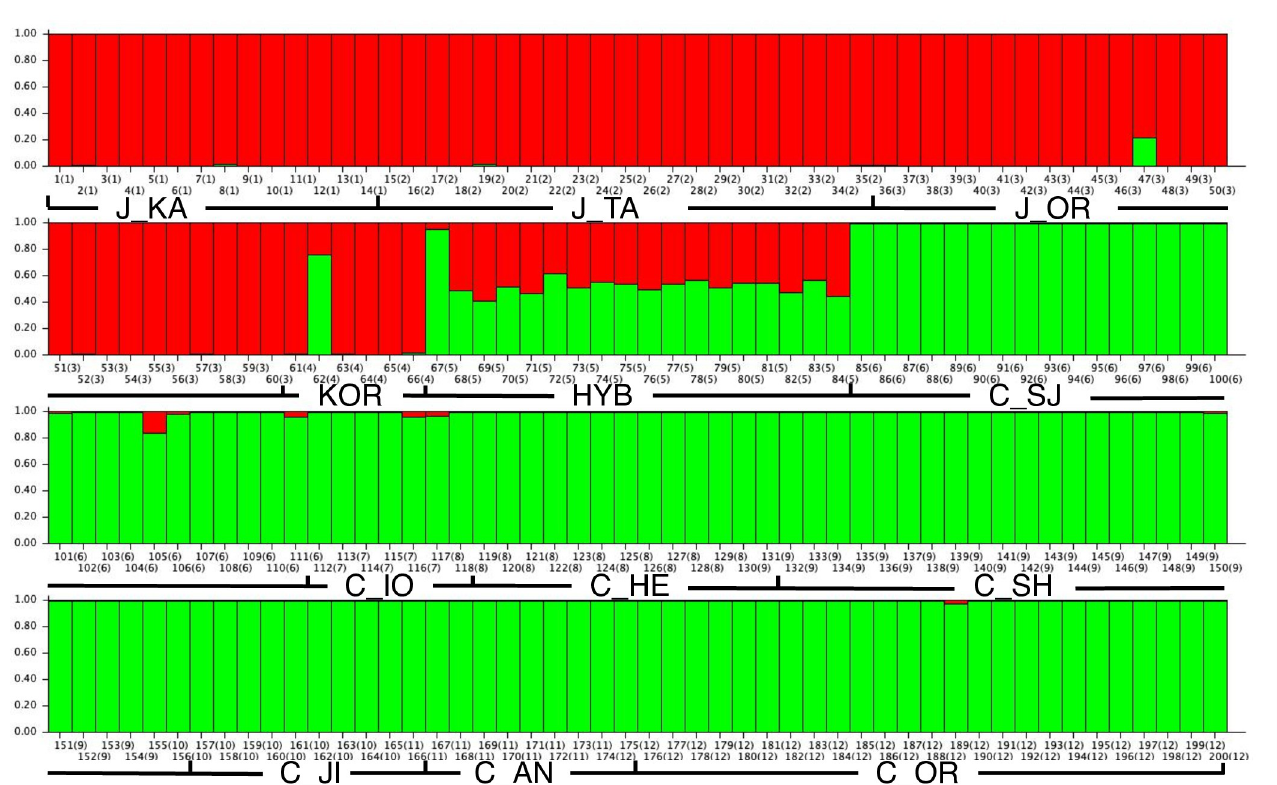
Fig 1. Detailed bar plot diagram for K = 2 in the independent model using 66 Japanese chestnut cultivars, 18 Japanese–Chinese hybrids, and 116 Chinese chestnut cultivars. The first number under each bar represents the individual accession ID number (1–200); the second number (in parentheses) represents the group number (1–12). ID numbers and groups are defined in Table